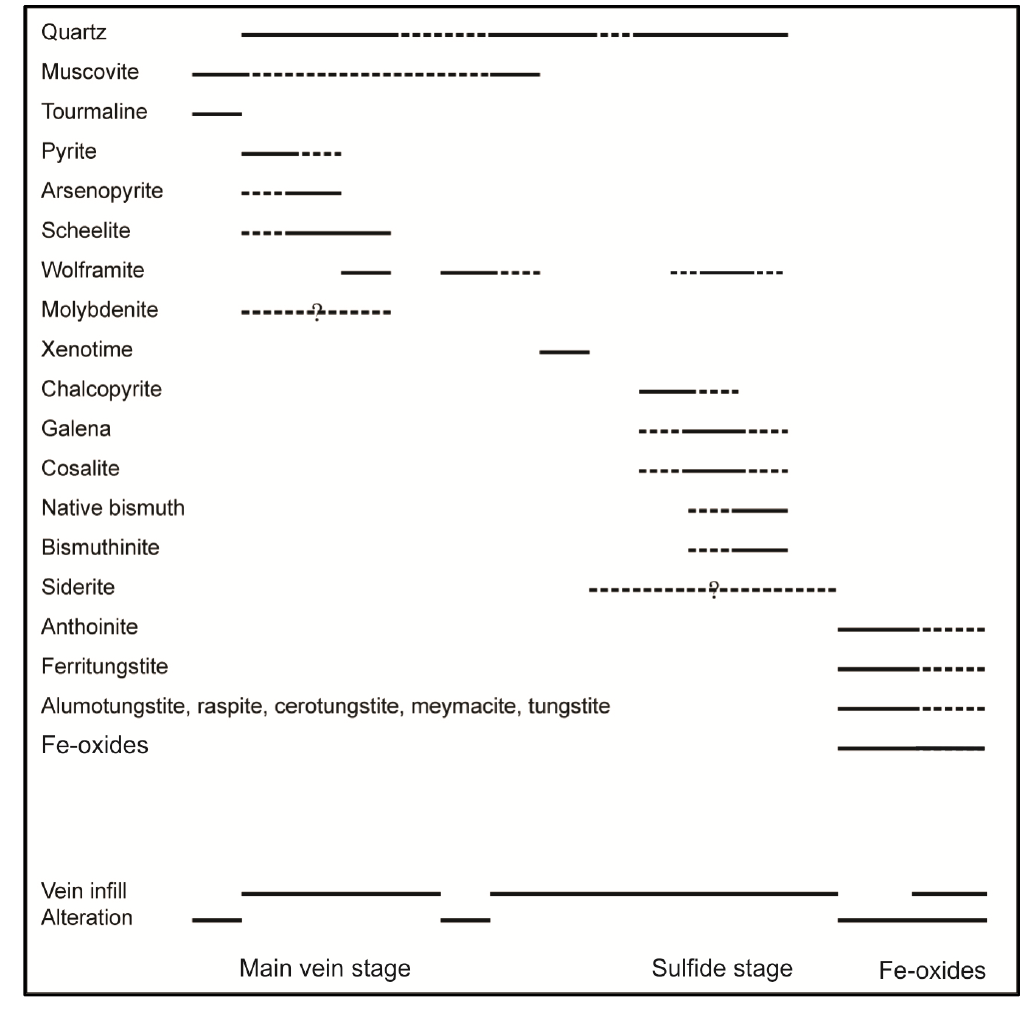
Figure 3. Paragenetic sequence of the W-mineralized quartz veins from tungsten deposits along the “tungsten belt” in central Rwanda (modified after [5]). Clear temporal relationships are marked by solid lines. Uncertain assignments are marked with dashed